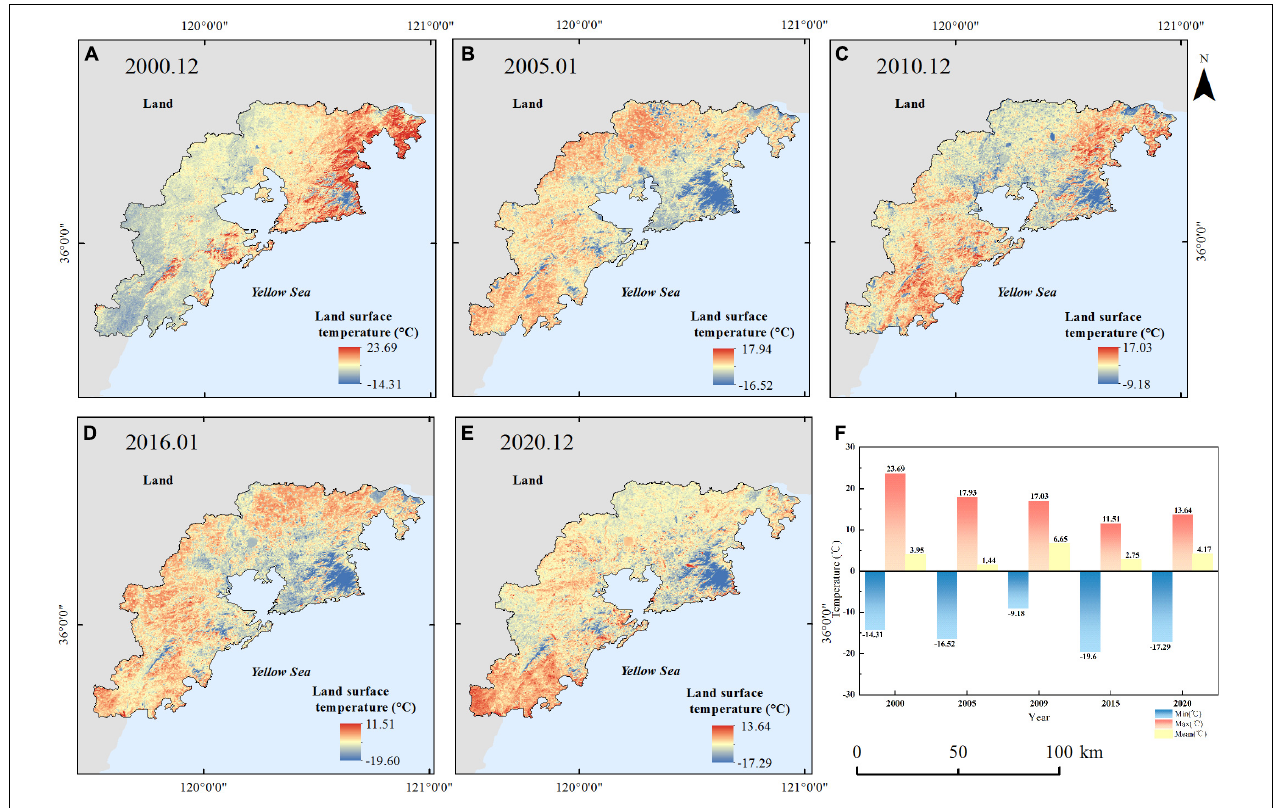
FIGURE 7 | Land surface temperature (LST) in winter from 2000 to 2020 (A) 2000.12, (B) 2005.01, (C) 2010.12, (D) 2016.01, (E) 2020.12, and (F) the max, mean, and min LST in winter from 2000 to